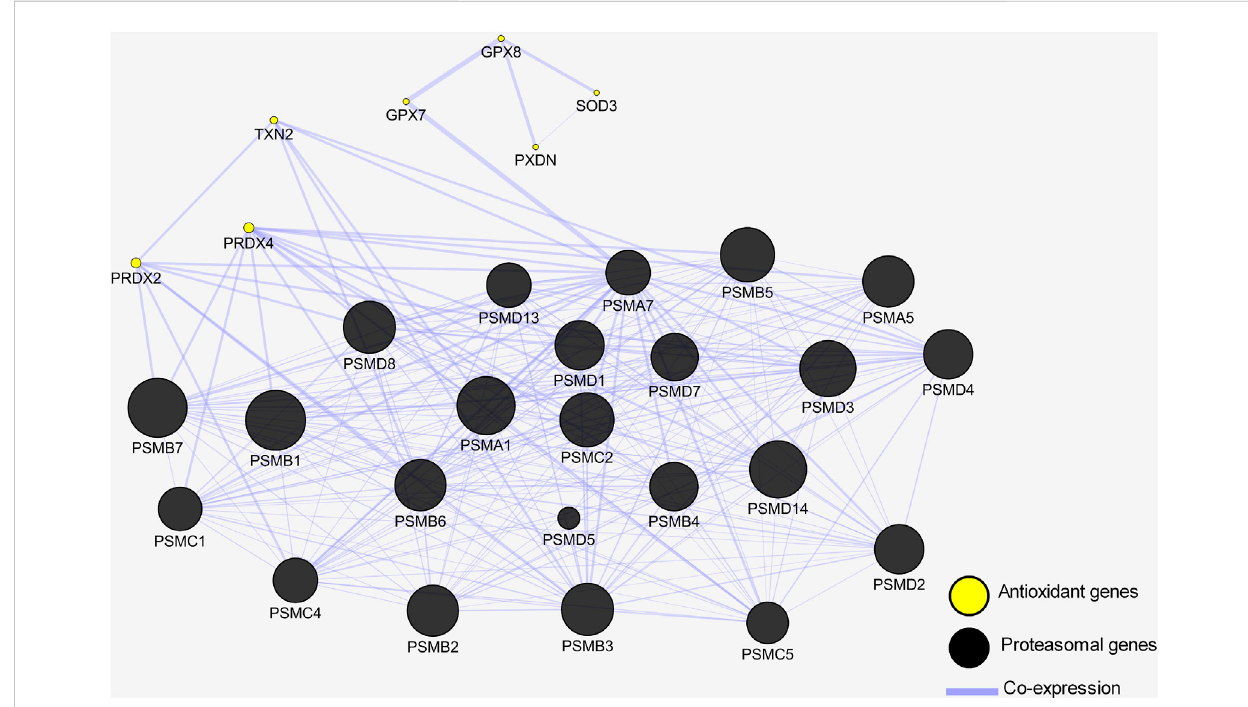
FIGURE 5 Gene interaction network shows antioxidant genes are co-expressed with proteasomal genes. Genes are depicted by nodes and the types of interaction are depicted by edges. Black circles represent proteasomal genes co-expressed with the antioxidant genes represented by yellow circles.